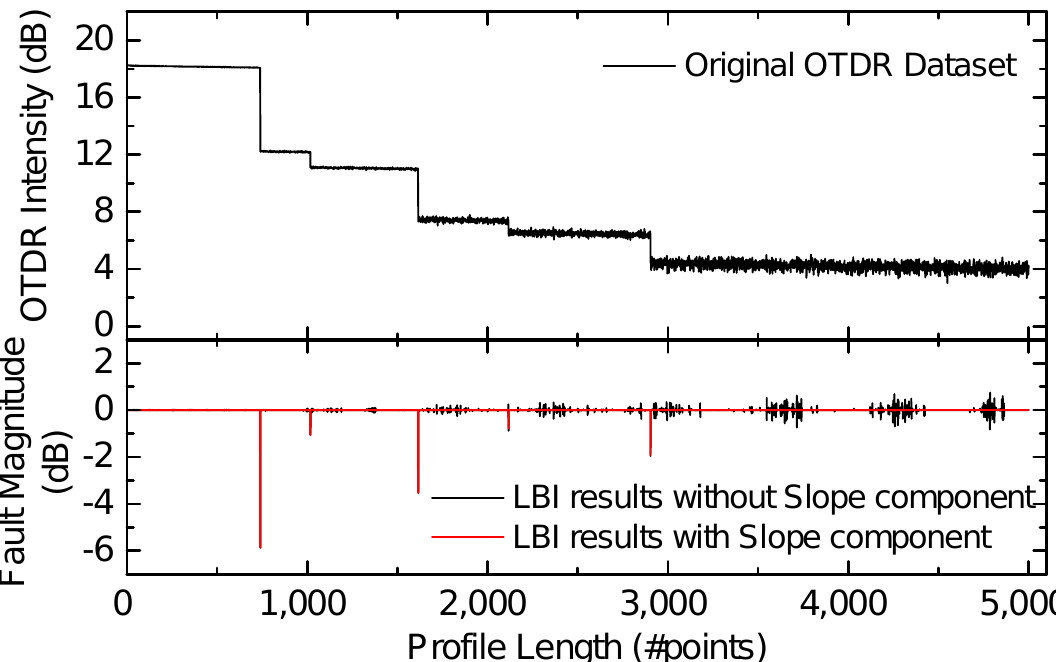
Figure 1. Effect of the inclusion of the slope component in the analysis of a fiber profile. In the upper panel, the original OTDR dataset containing the slope component is depicted. In the lower panel, two different LBI fault detection results are presented; when the slope is not included, a high incidence of false positives can be distinguished, which vanishes when the slope is